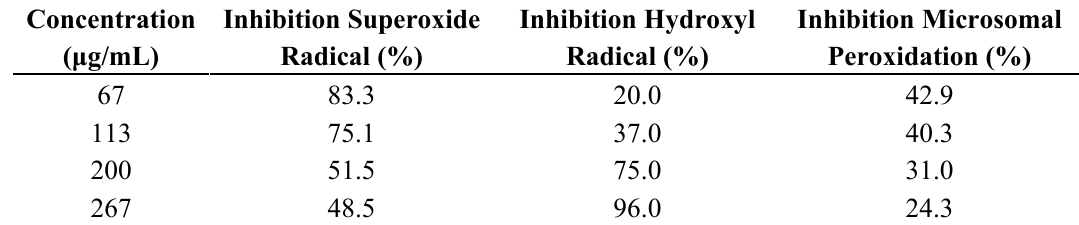
Table 2. The effect of mushroom polysaccharide extracts from P. dermoporus on superoxide and hydroxyl radical generation and microsomal lipid